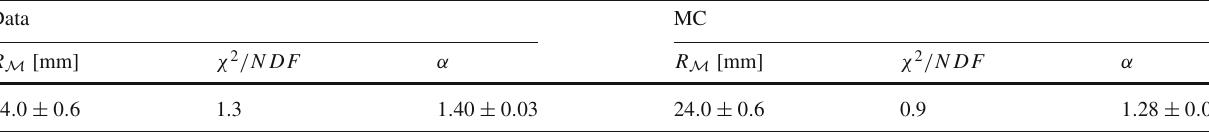
Table 3 The Molière radius results, data and MC simulation, together with the χ 2 / N DF and the value of α from the fit to the radial distribution